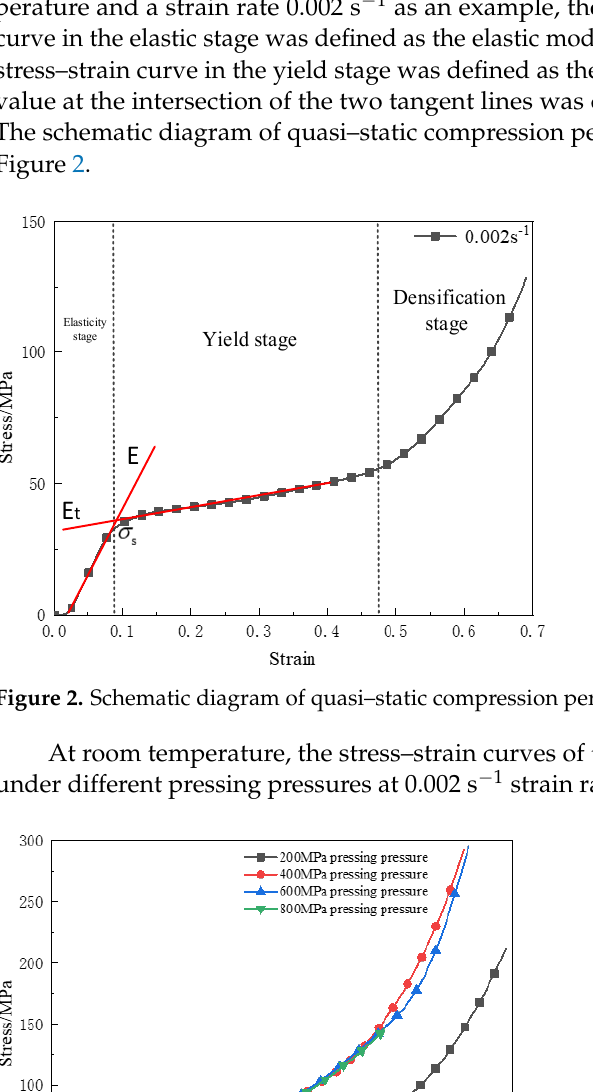
value at the intersection of the two tangent lines was defined as the yield strength σ s [5].